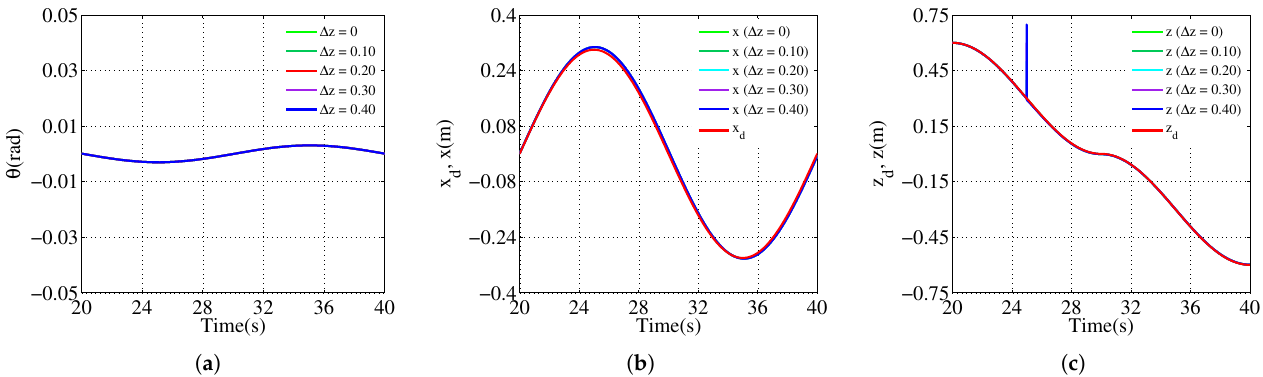
Figure 15. The simulation tests when ∆ x = 0,0.05,0.10,0.15, and 0.20. ( a ) The θ ; ( b ) the x d and x ; and ( c ) the z d and z .